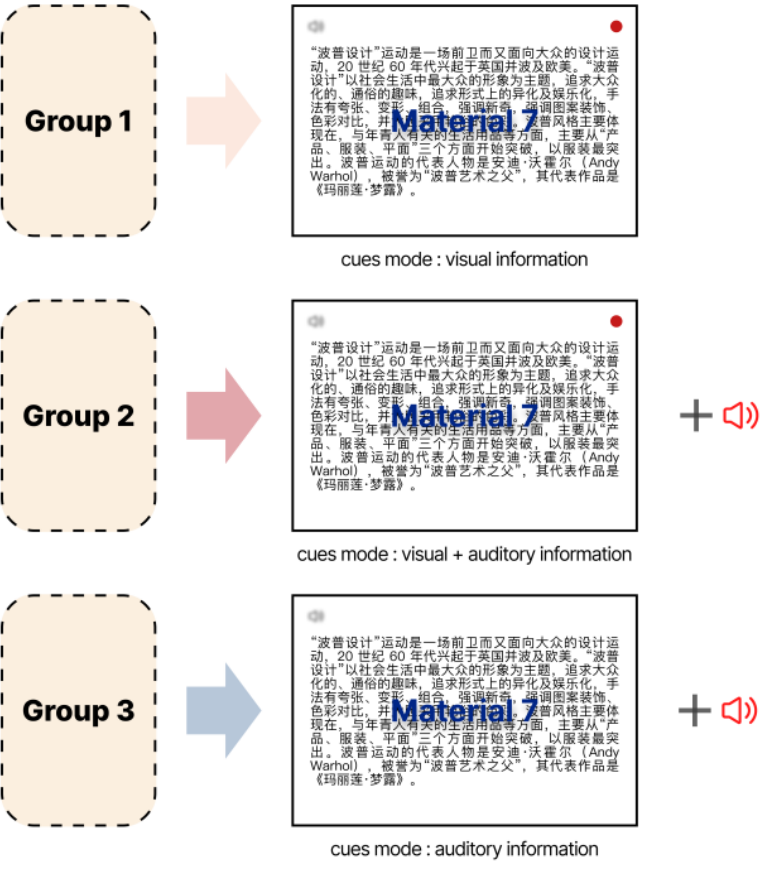
Figure 7. Experimental phase II procedure.